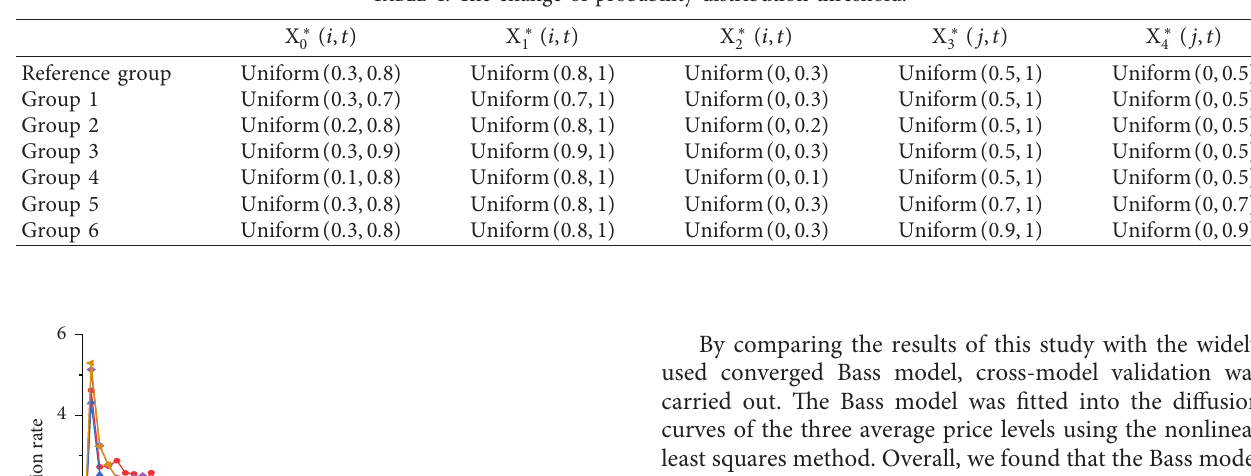
Figure 13: Sensitivity analysis for the scale of consumer agents. Table 4: The change of probability distribution threshold.